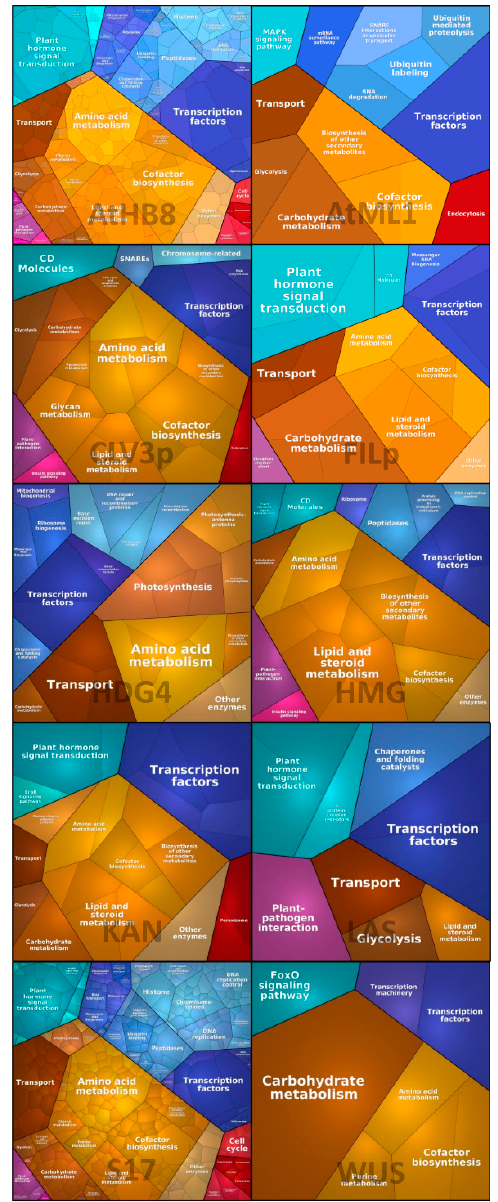
Figure 1. Voronoi Tree-maps for the visualization of differentially expressed genes (DEGs) of the SAM cellular populations with hierarchical classification based on KEGG pathways. The DEGs of the 10-SAM cellular populations (HGD, FILP, CLV3p, AtMIL, AtHB8; upper row: WUS, S17, LAS, KAN, and HMG: Lower row) are separately visualized via the Bionic Visualization tool (https://bionic-vis.biologie.uni-greifswald.de/). To get functional insight, and for global understanding of multiple gene expression datasets belonging to various cellular populations of the SAM, the visualization of the functional relatedness of the genes is displayed here by tessellations: Each gene is shown by a polygon and functionally related genes are arranged in common and similarly colored regions. Main functional categories (KEGG ontologies) are shown with different color codes, such as metabolism, genetic information processing, plant-pathogen interactions, and environmental information processing, as well as cellular processes, such as cell growth, mobility, and cell death.